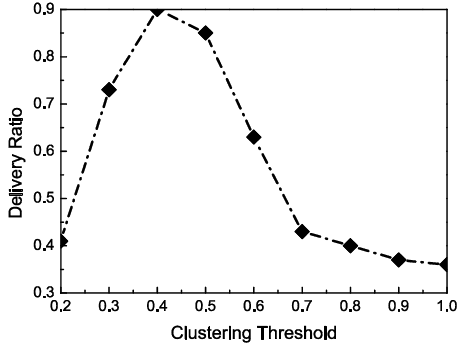
Figure 9. Impact of the Threshold of Contact Probabilty for Clultering on Delivery Ratio. According to Equation (14), the probability of one node, node i , in its H is 𝑃